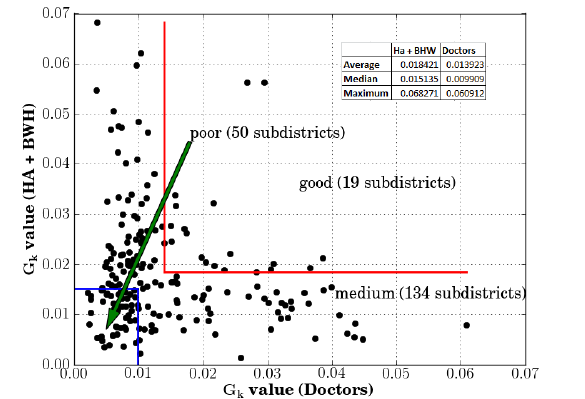
Figure 11: Classification of sub-districts using Gk values of both the providers for the reference